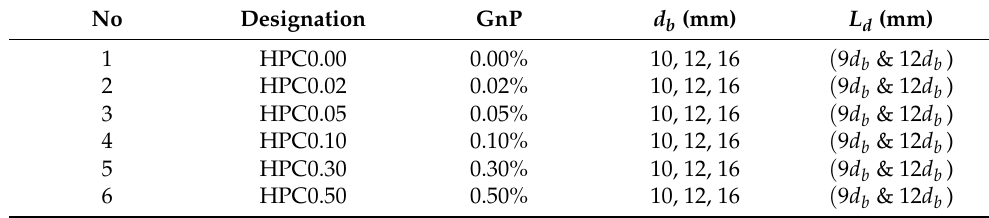
Table 1. Details of concrete designations and variables.